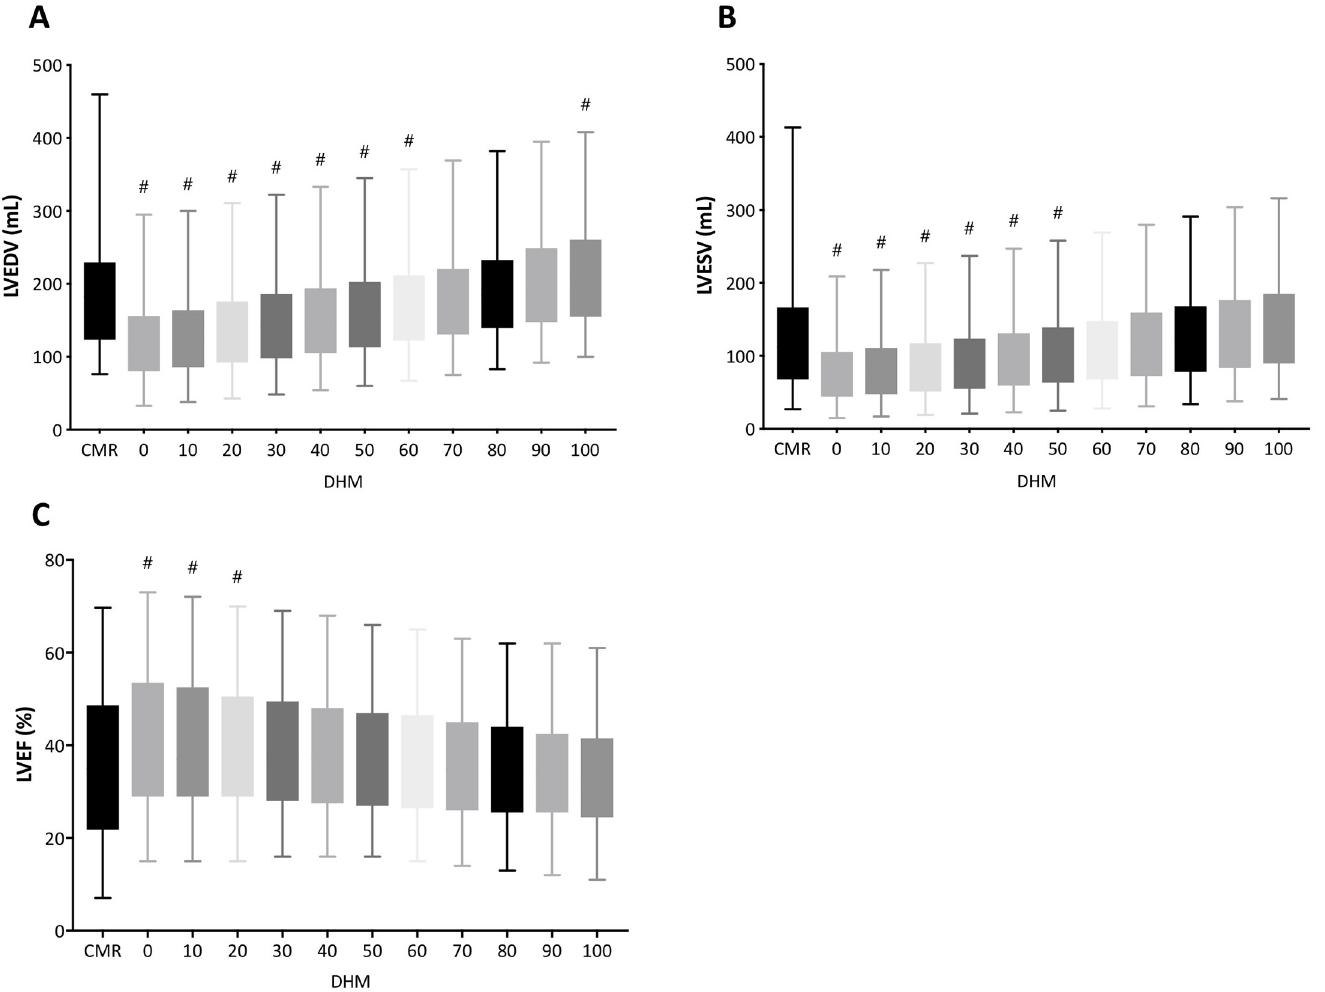
Fig 2. Box and whiskers (minimum to maximum) of left ventricular end-diastolic volume (A), left ventricular end-systolic volume (B), and left ventricular ejection fraction (C) between cardiac magnetic resonance disk-summation method and 3D echocardiography with automated quantification software (Dynamic HeartModel) according to change in border setting. LVEDV, end-diastolic volume; LVEF, left ventricular ejection fraction; LVESV, left ventricular end-systolic volume. #: p < 0.05 compared with CMR.